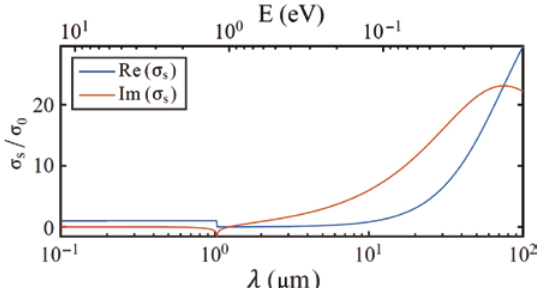
Figure 1: Dispersion of the complex sheet conductance of graphene in the interband and intraband wavelength range. Reproduced from Ref. [26].